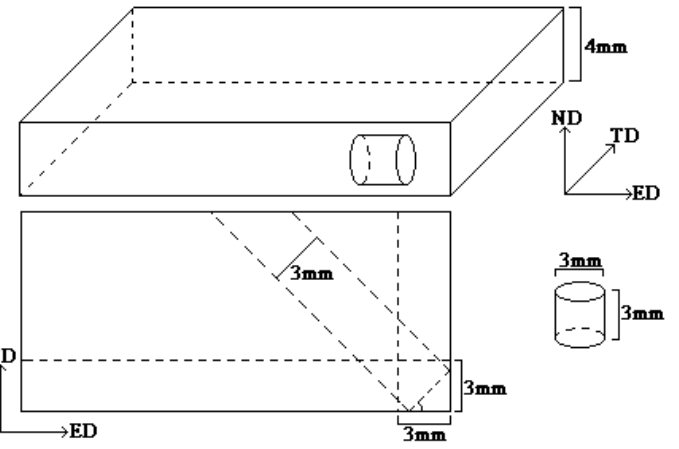
Figure 1. Schematic diagram of preparing Φ 3 mm × 3 mm cylindrical samples for high strain rate